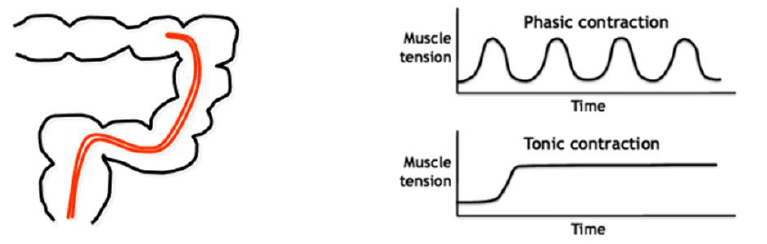
Figure 10. Schematic representation of the manometry catheter positioned inside the left colon ( left ), and of the phasic and tonic motor activity ( right ).